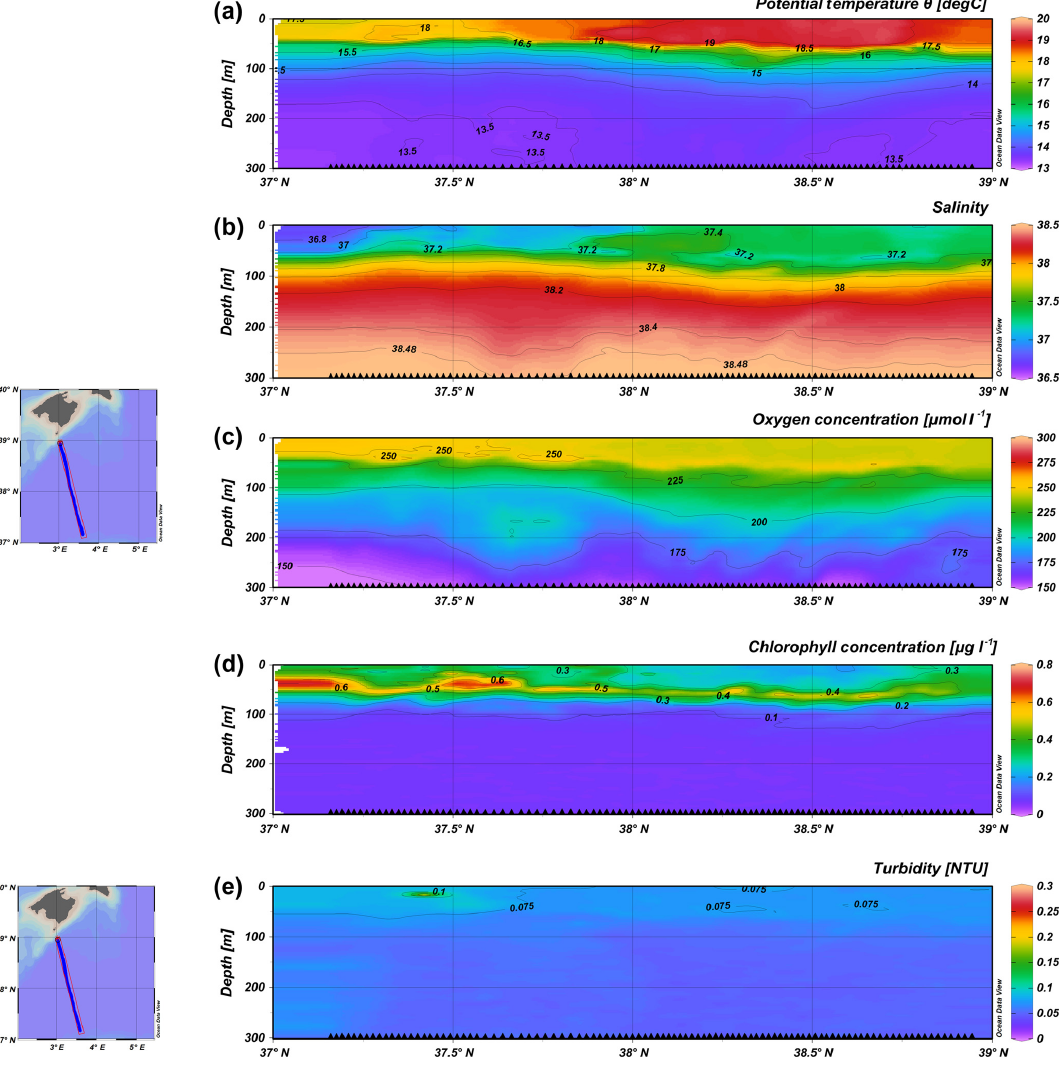
Figure 8. Surface layer (0–300m depth) along-track sections of potential temperature (a) , salinity (b) and oxygen concentration (c) obtained from ABACUS 3 glider data. Black triangles indicate the position of the single glider